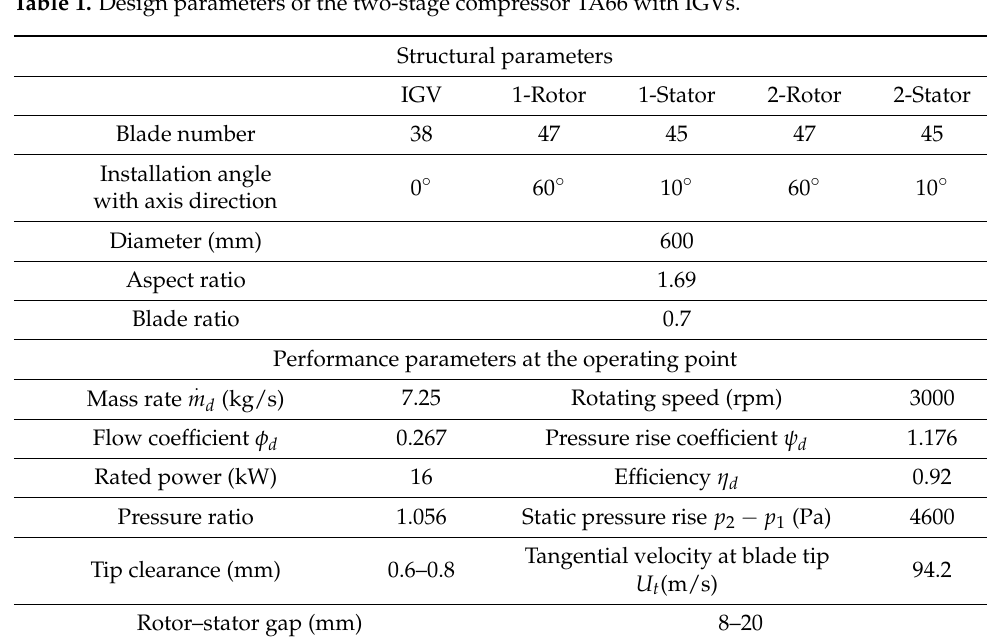
Figure 1. Schematic of the structure and measurement arrangement of the two-stage TA66 with an IGV. Table 1. Design parameters of the two-stage compressor TA66 with